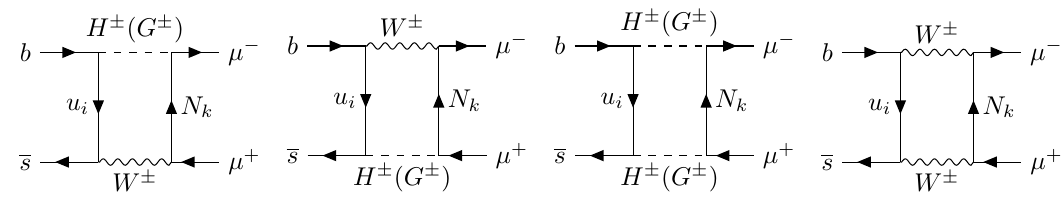
(cid:0) transition in the 2HDM-III embedded with